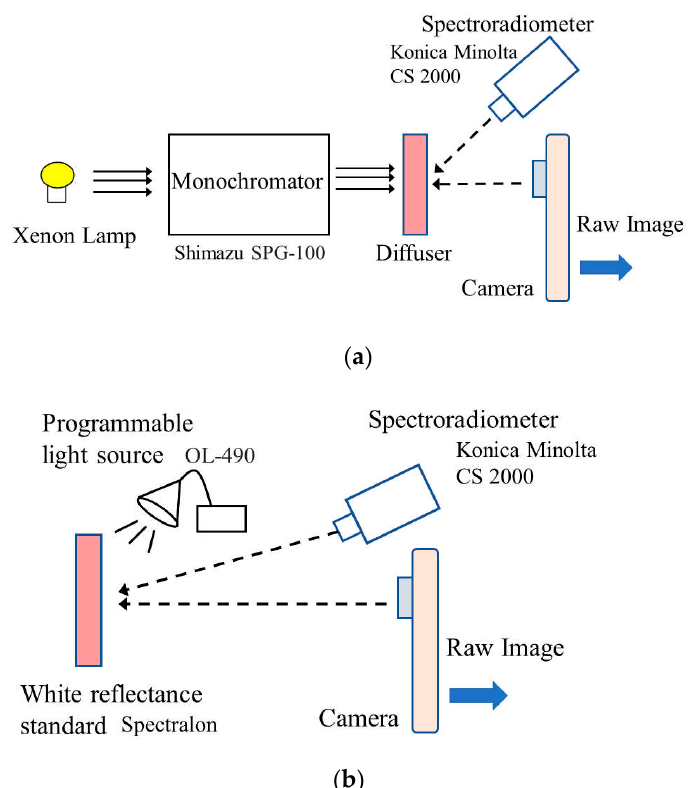
Figure 2. Experimental setups for measuring the spectral responses of mobile phone cameras using monochromatic light and a spectrometer. ( a ) Monochromatic light from monochromator grating. ( b ) Monochromatic light from a programmable light source.